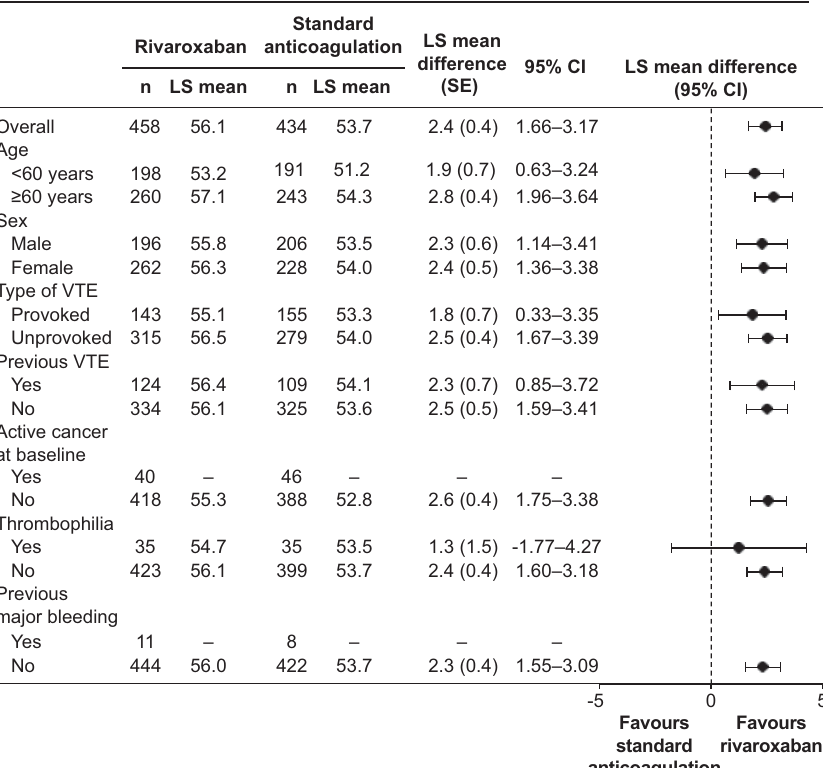
Fig. 1 ACTS Burdens score least squares mean differences by subgroup (PMS-ACTS analysis set). Subgroups with missing values had too few patients to enable LS mean difference to be calculated. ACTS, Anti-Clot Treatment Scale; CI, con fi dence interval; LS, least squares; PMS, propensity score-matched set; SE, standard error; VTE, venous